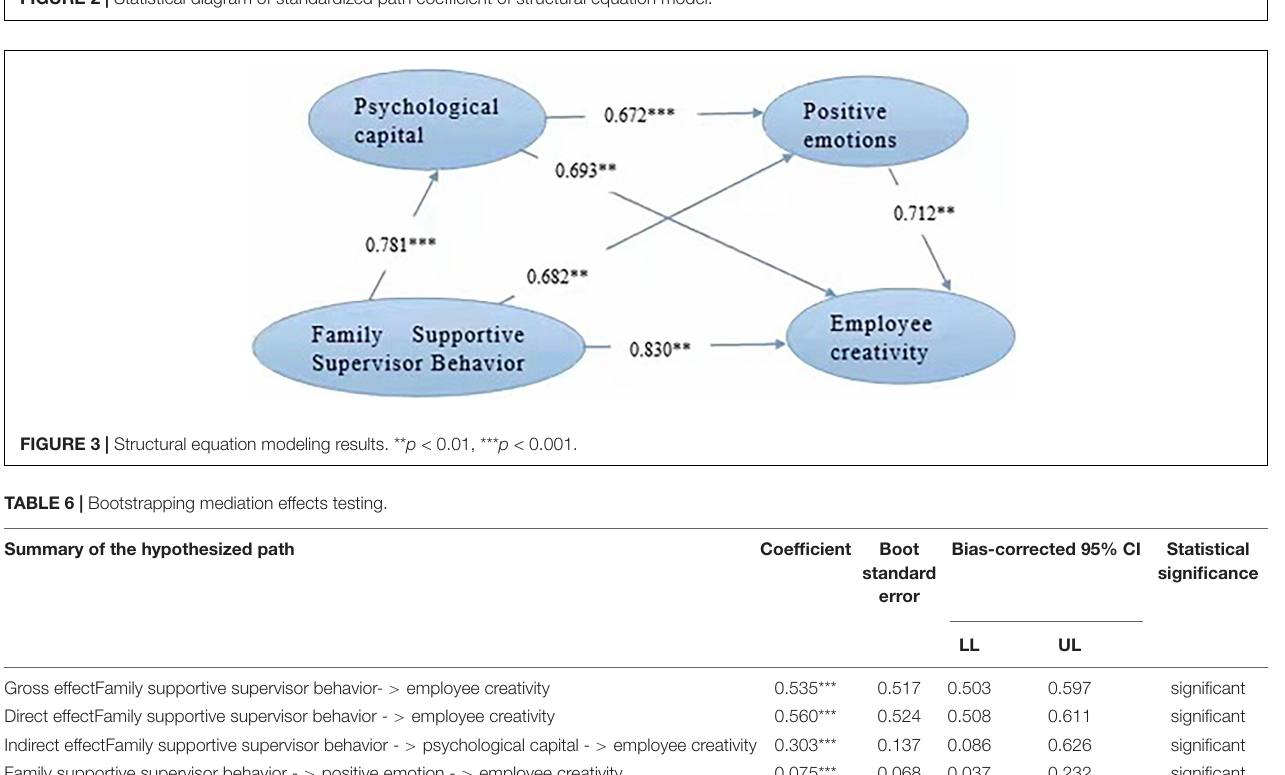
FIGURE 2 | Statistical diagram of standardized path coefficient of structural equation model.